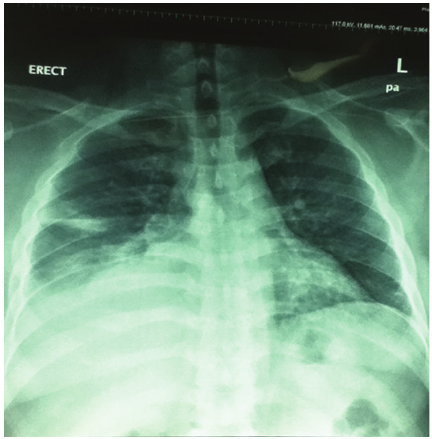
Figure 2: Chest X-ray on admission showed infiltrates and pleural e ff usion on the right lower zone.